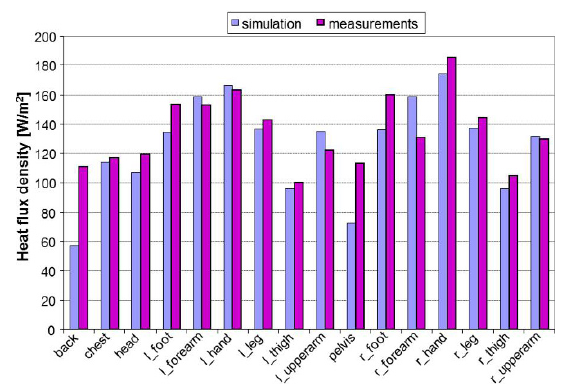
simulations has demonstrated good performance of the numerical predictions with few exceptions. The first discrepancy is where dimensionless wall distance was not maintained, and the second discrepancy is with a measurement value possibly lying outside the feasible range of the physical